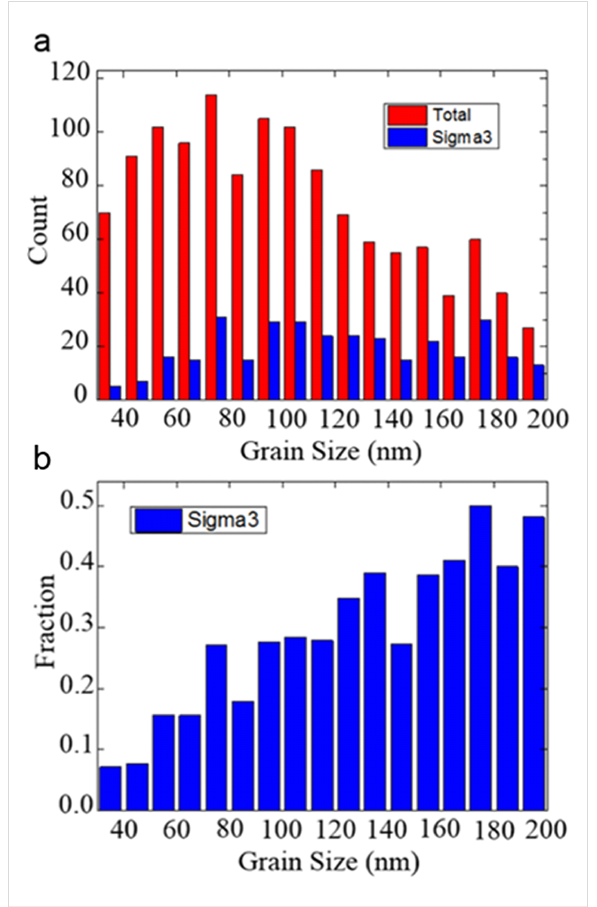
Figure 4: (a) Grain size distribution and the size distribution of twinned grains indicated by red and blue histogram, respectively. (b) Histogram showing the fraction of grains that are twinned in each size